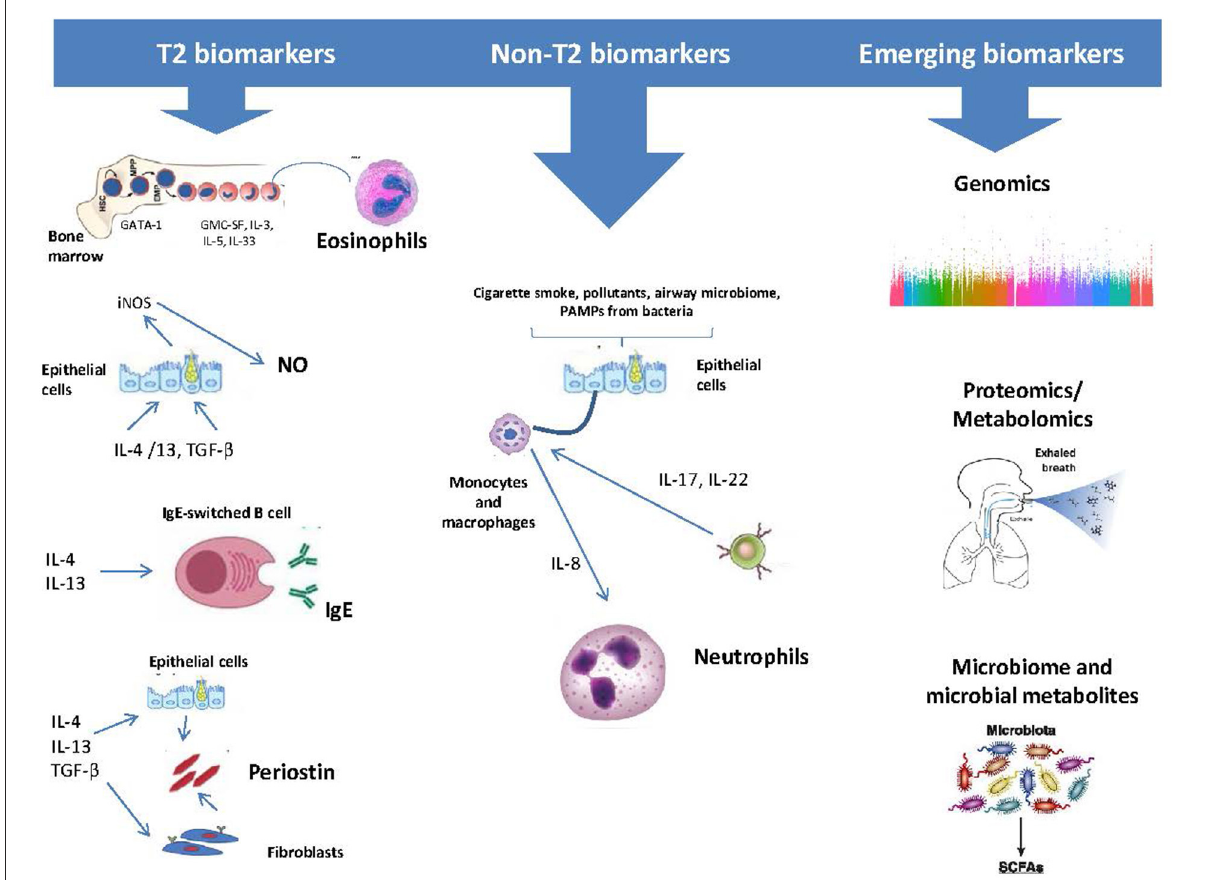
FIGURE1 Asthma biomarkers categorized as those related to type 2 (T2) Inflammation and those that relate to other biological